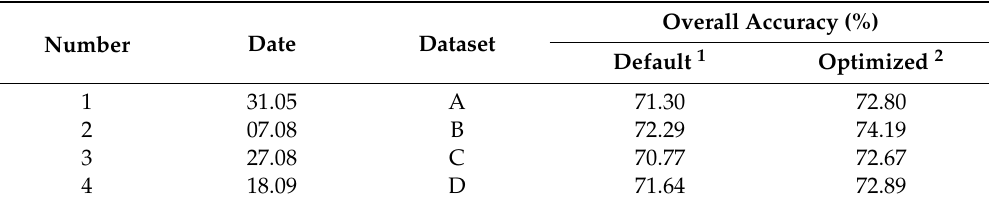
Table 3. Overall accuracies obtained for single-date datasets and di ff erent support vector machine (SVM)